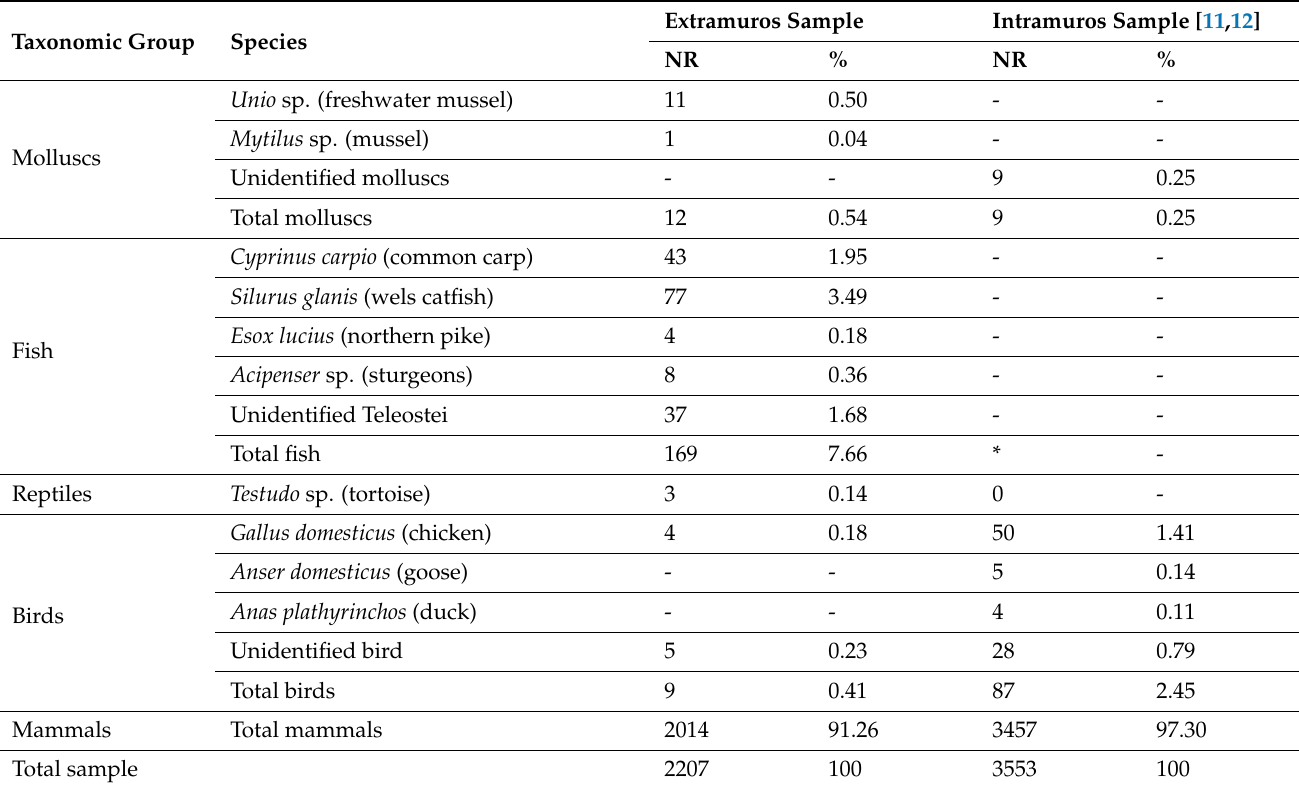
Table 3. Halmyris, Romania (4th–6th centuries AD). Distribution of animal remains by taxonomic groups (NR = number of